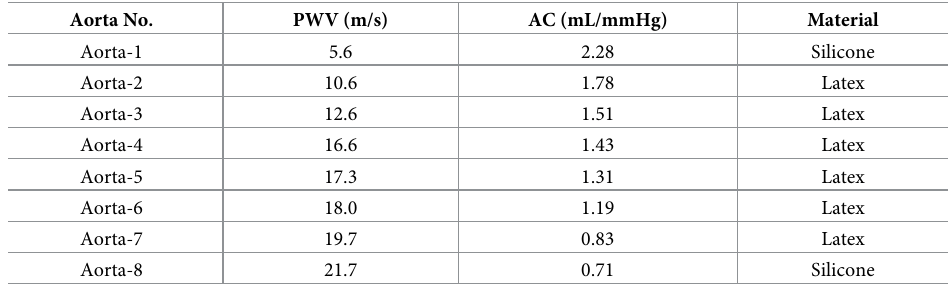
Table 2. Dynamic and physiological properties of the fabricated